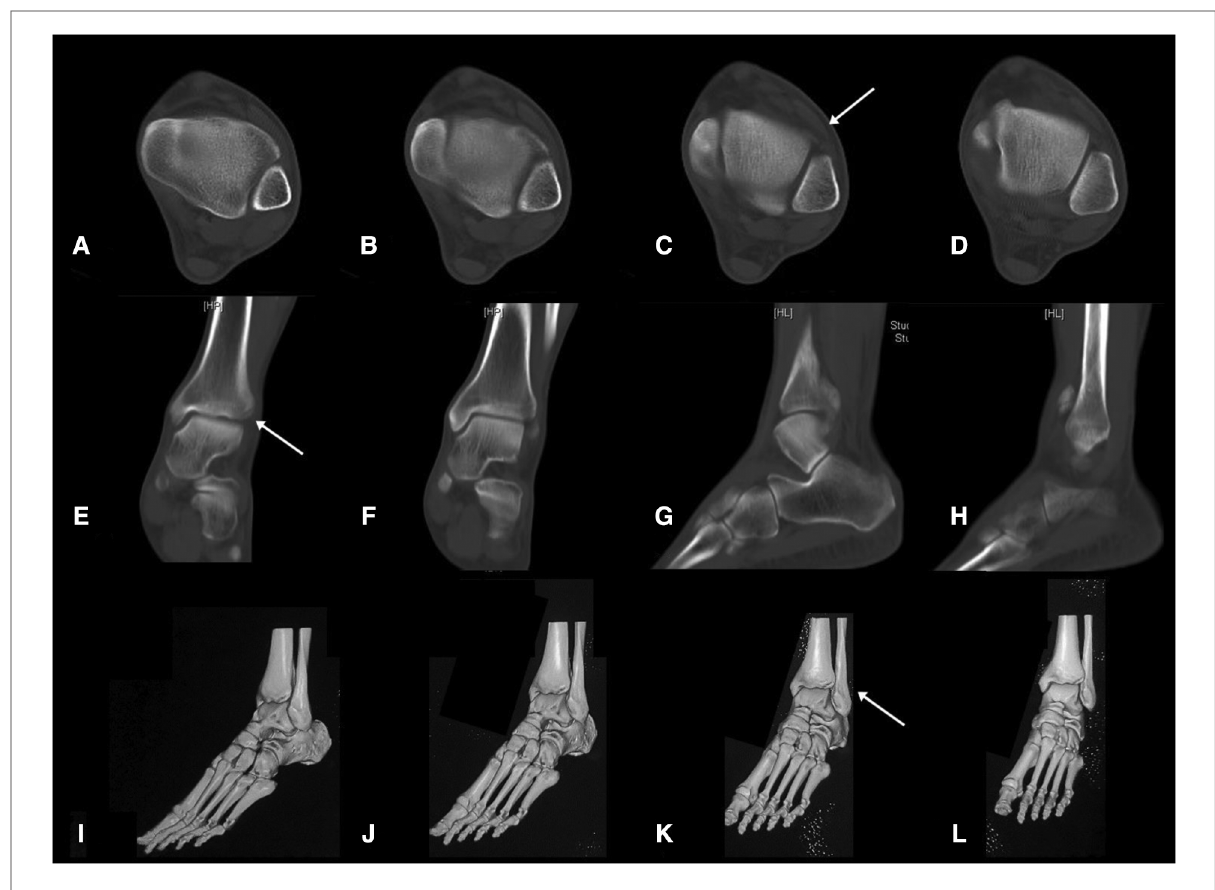
FIGURE 2 The initial transverse view ( A – D ), coronal view ( E,F ), and sagittal view ( G,H ) CT images of the ankle, and 3D reconstruction image of the foot and ankle ( I – L